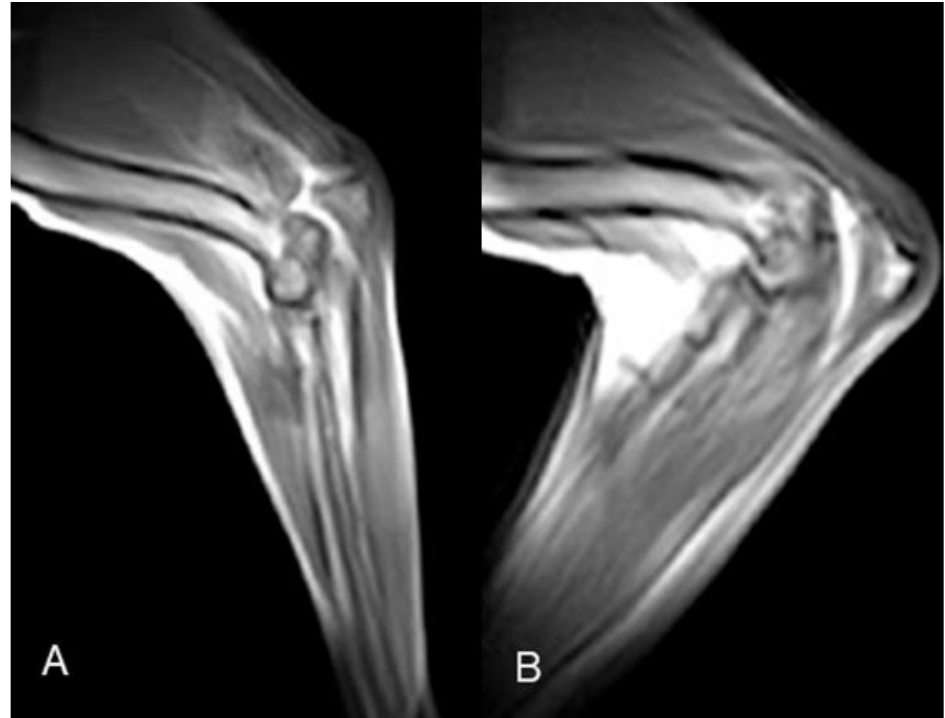
Figure 4. Case 6 elbow k-MRI sample images. ( A ) Neutral starting position; ( B ) point of maximum flexion. 202